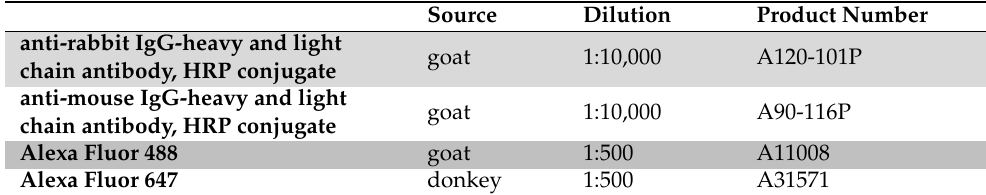
Table 2. Secondary antibodies used in Western blot analysis and Immunofluorescence. Secondary antibodies used in this thesis are listed concerning their name, source, dilution ratio.